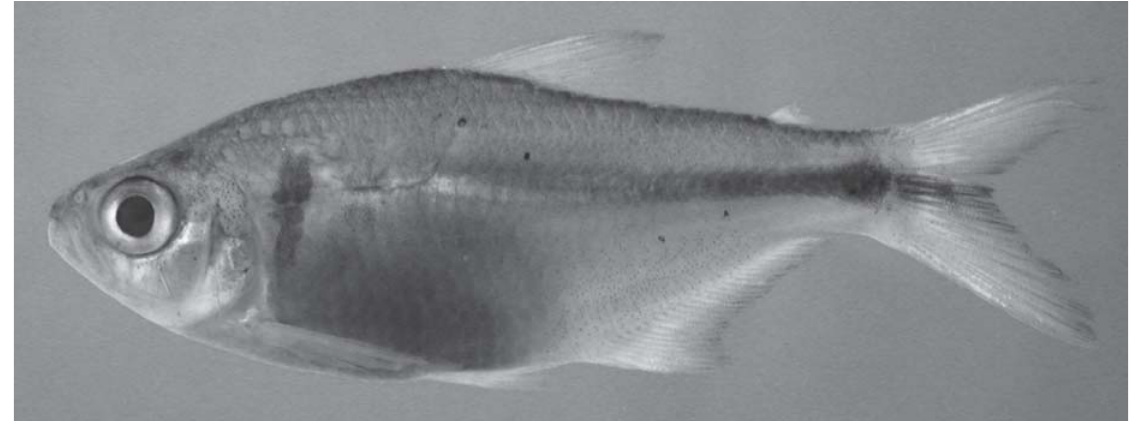
Fig. 4. Astyanax henseli , MNRJ 14186, 64.5 mm SL, female, arroio do Carvalho, rio dos Sinos drainage, Vila do Carvalho,